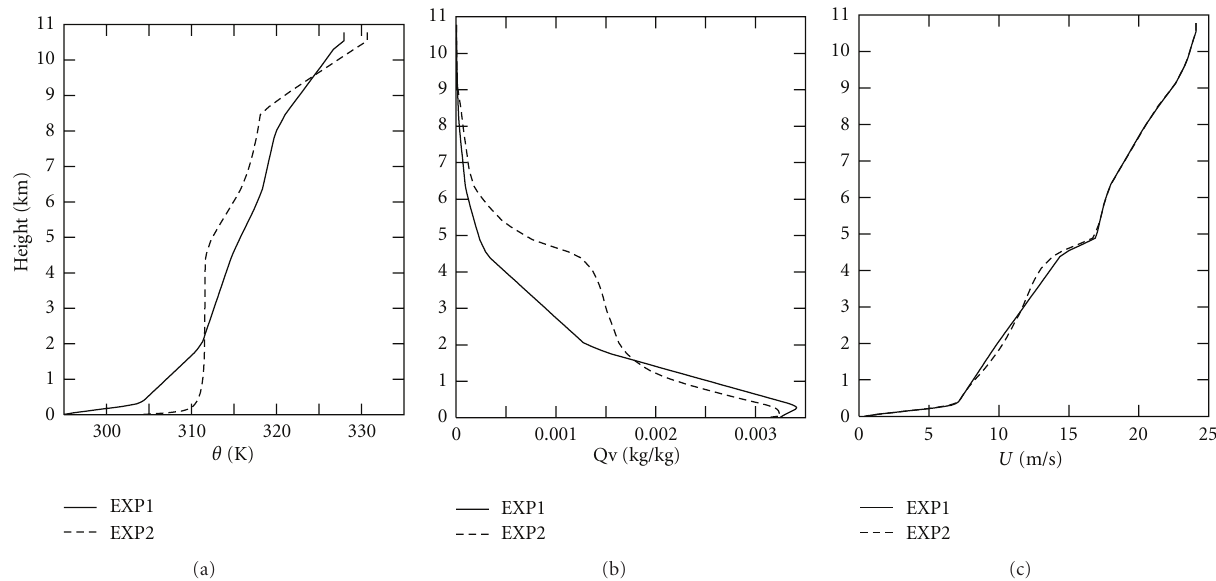
Figure 1: Initial vertical profiles of (a) potential temperature (in K), (b) water vapor mixing ratio (in kgkg − 1 ), and (c) horizontal wind speed (in ms − 1 , x -component) for the EXP1 (solid lines) and the EXP2 cases (broken lines).